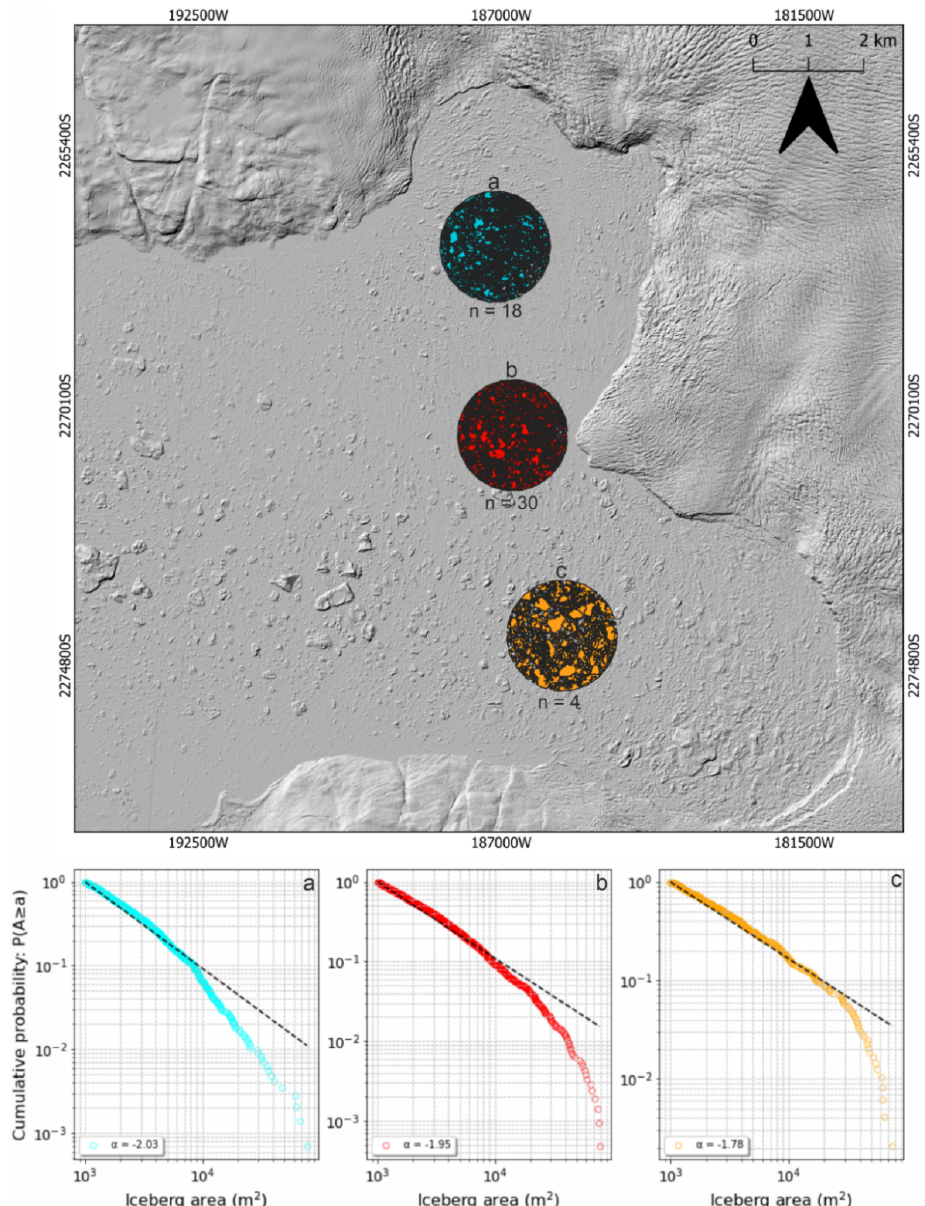
Figure 10. Subset sampling across SKJI’s ice front to determine how iceberg distributions change spatially. Overlaying the hillshaded ArcticDEM image are the total iceberg collections for each subset with the respective power law slopes beneath, corresponding by both letter and colour. The “ n ” underneath each iceberg collection is the number of available DEMs within the subsetted